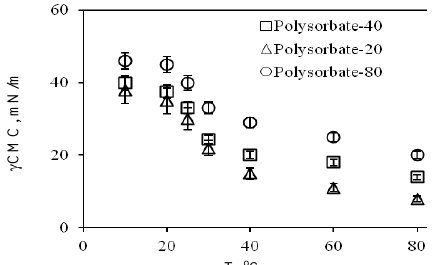
Figure 3. The variation of surface tension at CMC as a function of temperature for different surfactants.